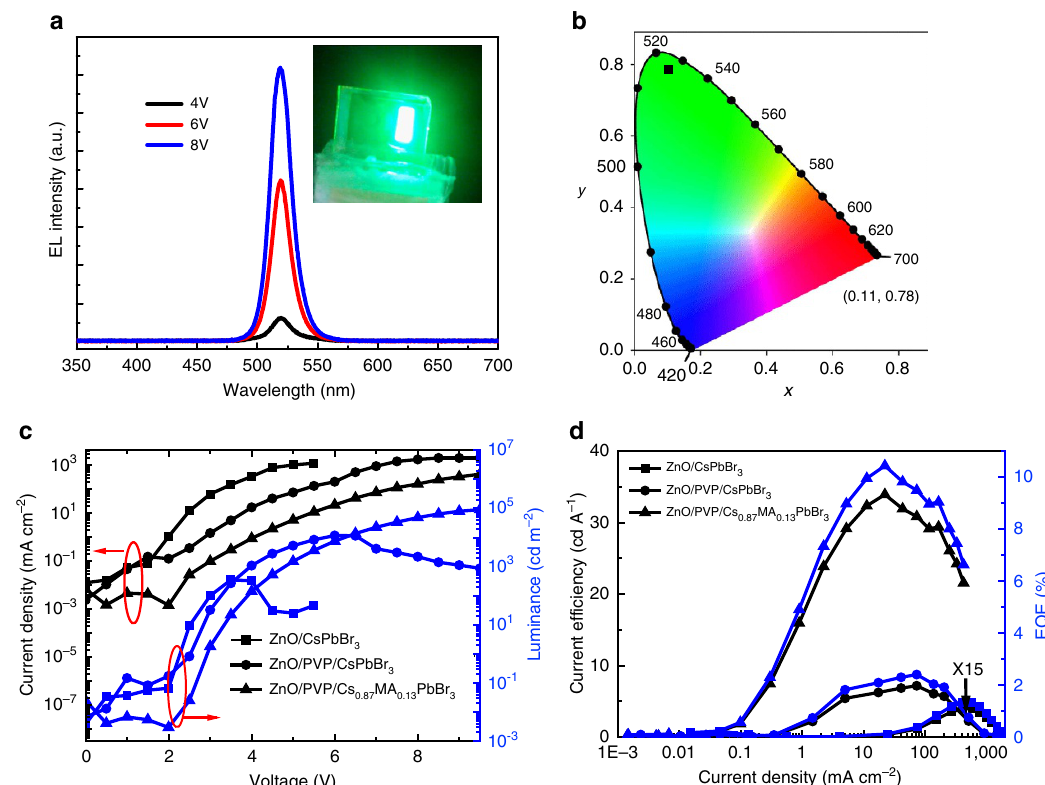
Figure 4 | EL performance of the devices. ( a ) EL spectra of Cs 0.87 MA 0.13 PbBr 3 -based devices under varying voltage bias (the emission image is shown in inset). ( b ) The corresponding CIE coordinate. ( c ) I – V and voltage–light intensity ( L – V ) curves for the devices with and without PVP buffer layer or with and without CH 3 NH 3 Br (MABr) additive, that is, ZnO/CsPbBr 3 , ZnO/PVP/CsPbBr 3 and ZnO/PVP/Cs 0.87 MA 0.13 PbBr 3 , respectively, here PVP is polyvinyl pyrrolidine. ( d ) Current efficiency and EQE of devices with and without PVP buffer layer, with and without CH 3 NH 3 Br (MABr) additive, that is, ZnO/CsPbBr 3 , ZnO/PVP/CsPbBr 3 and ZnO/PVP/Cs 0.87 MA 0.13 PbBr 3 ,